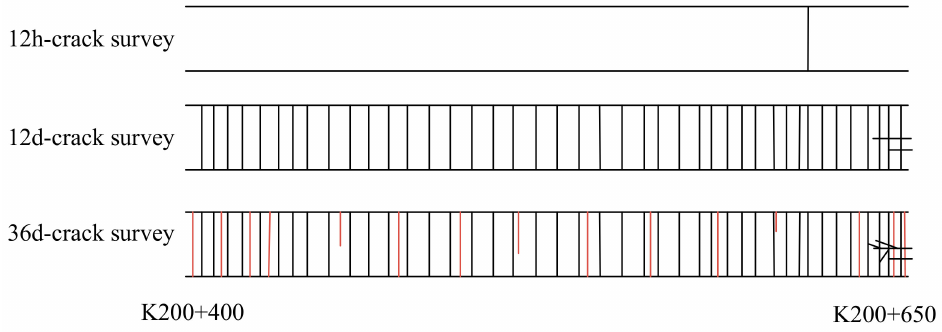
Figure 3. Crack maps of the BFRP-CRCP test section from crack